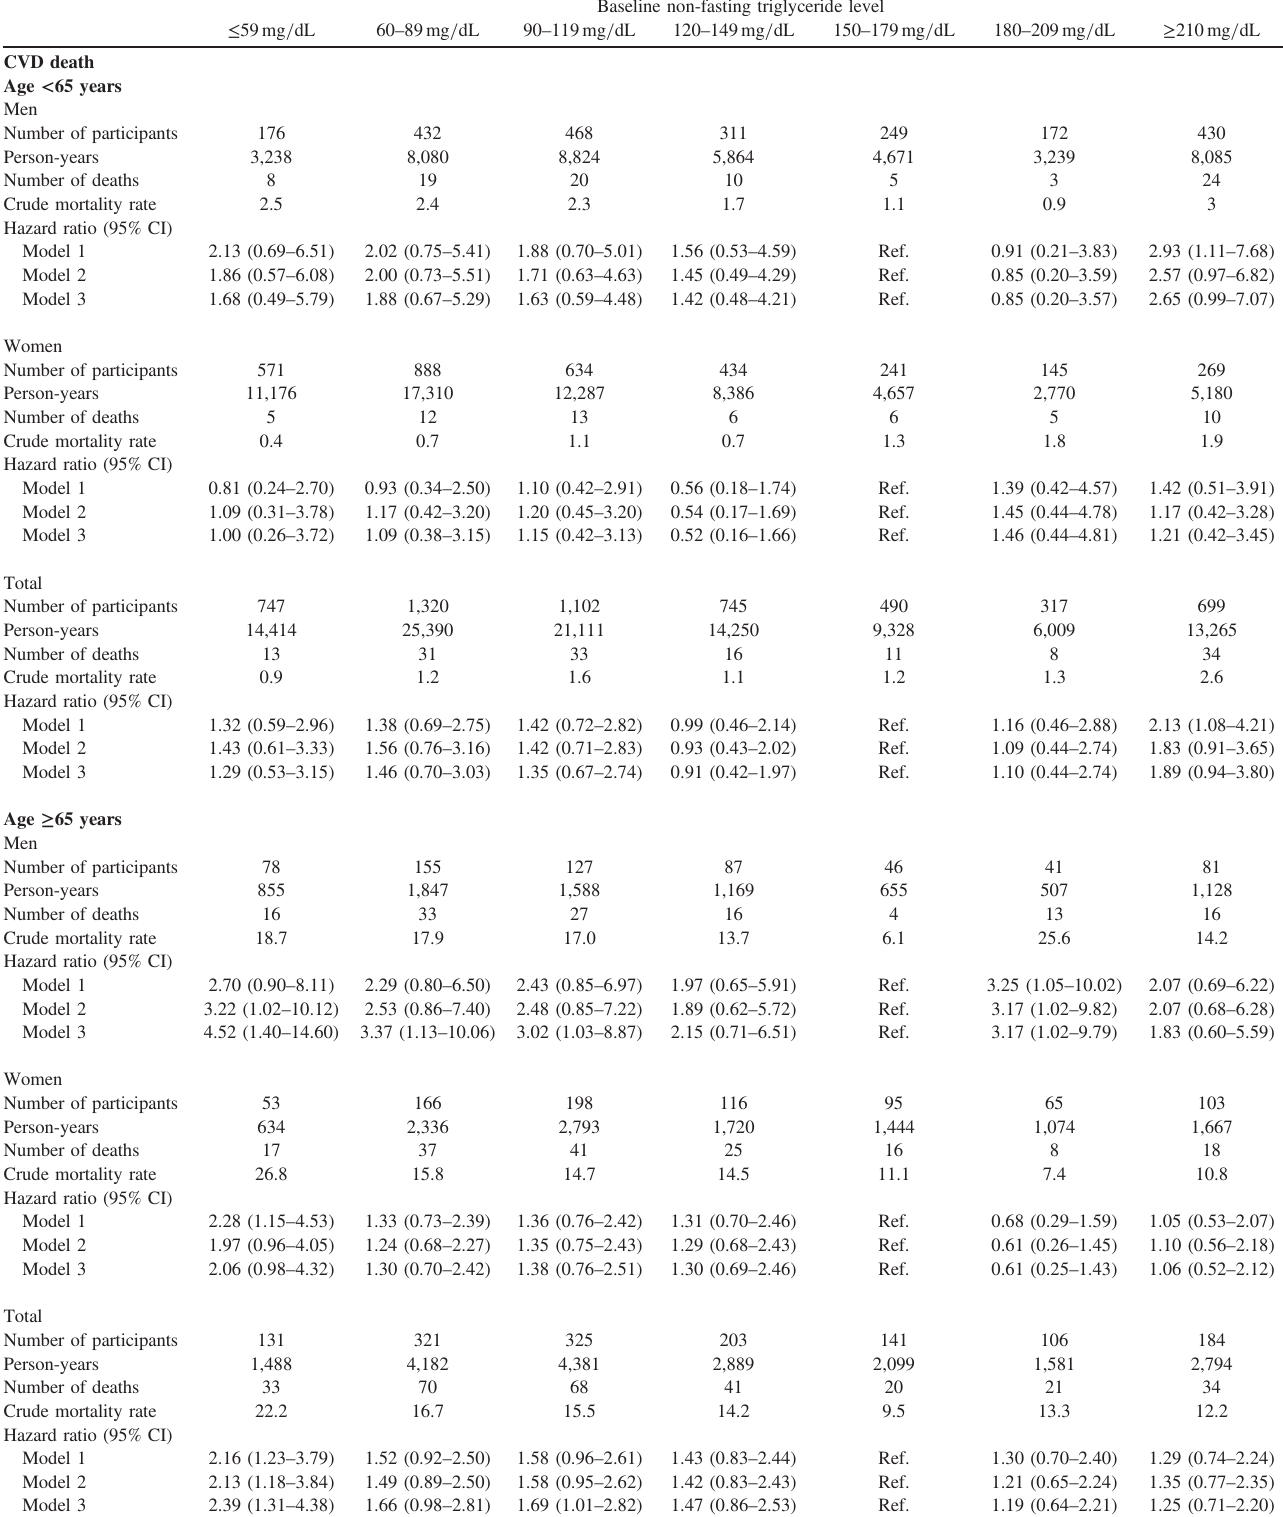
Table 5. Crude mortality rates and hazard ratios for CVD mortality according to non-fasting triglyceride category strati fi ed by age < 65 and ; 65